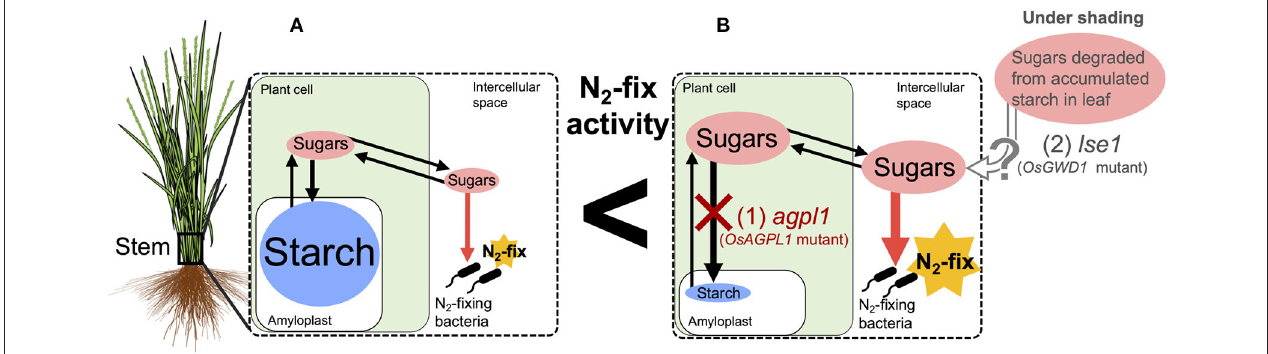
FIGURE 9 | Hypothetical model of the relationship between nitrogen (N) fixation and sugars in the stem of rice. Endophytic N 2 -fixing bacteria are expected to use sugars (sucrose and/or glucose) in the intercellular spaces as carbon (C) sources for N fixation. (A) Most Oryza sativa varieties, such as Nipponbare, accumulate starch as a major non-structural carbohydrate in their stems with small amounts of sugar in the intercellular space, which may be utilized by N 2 -fixing bacteria. (B) CG14, a variety of O. glaberrima, and agpl1 , a mutant lacking a starch synthesis gene in shoot (1), accumulate sugars in the parenchyma. lse1 , which lacks a starch degradation gene in leaf and accumulates high starch in leaves (2), is supposed to translocate sugars derived from starch to the stem under the shading treatment. Higher amount of sugars in the intercellular spaces possibly enhance N fixation.